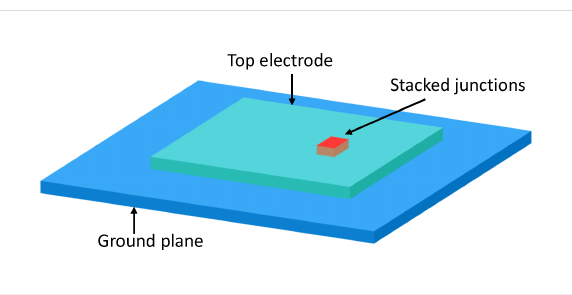
Figure 4: A proposed design of the impedance-matched free-space Josephson oscillator. Here, a small stack of Josephson junctions (red) is sandwiched between two large superconducting electrodes, namely the ground plane (blue) and the top electrode (light blue). The stack is acting as a source of microwave current (feed-in) for the patch antenna formed by the electrodes.